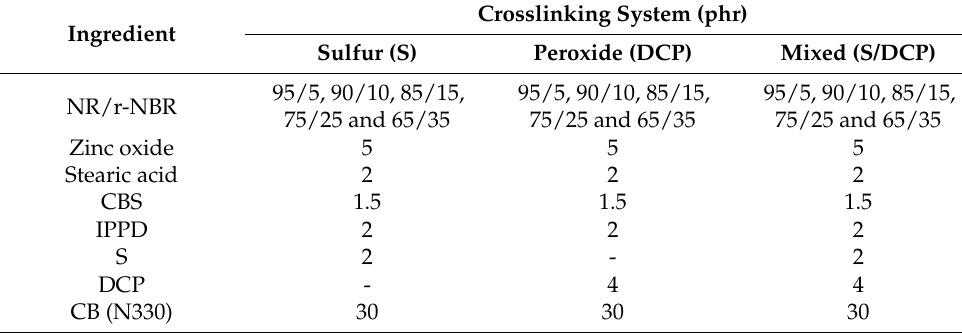
Table 1. Ingredients used for preparing the